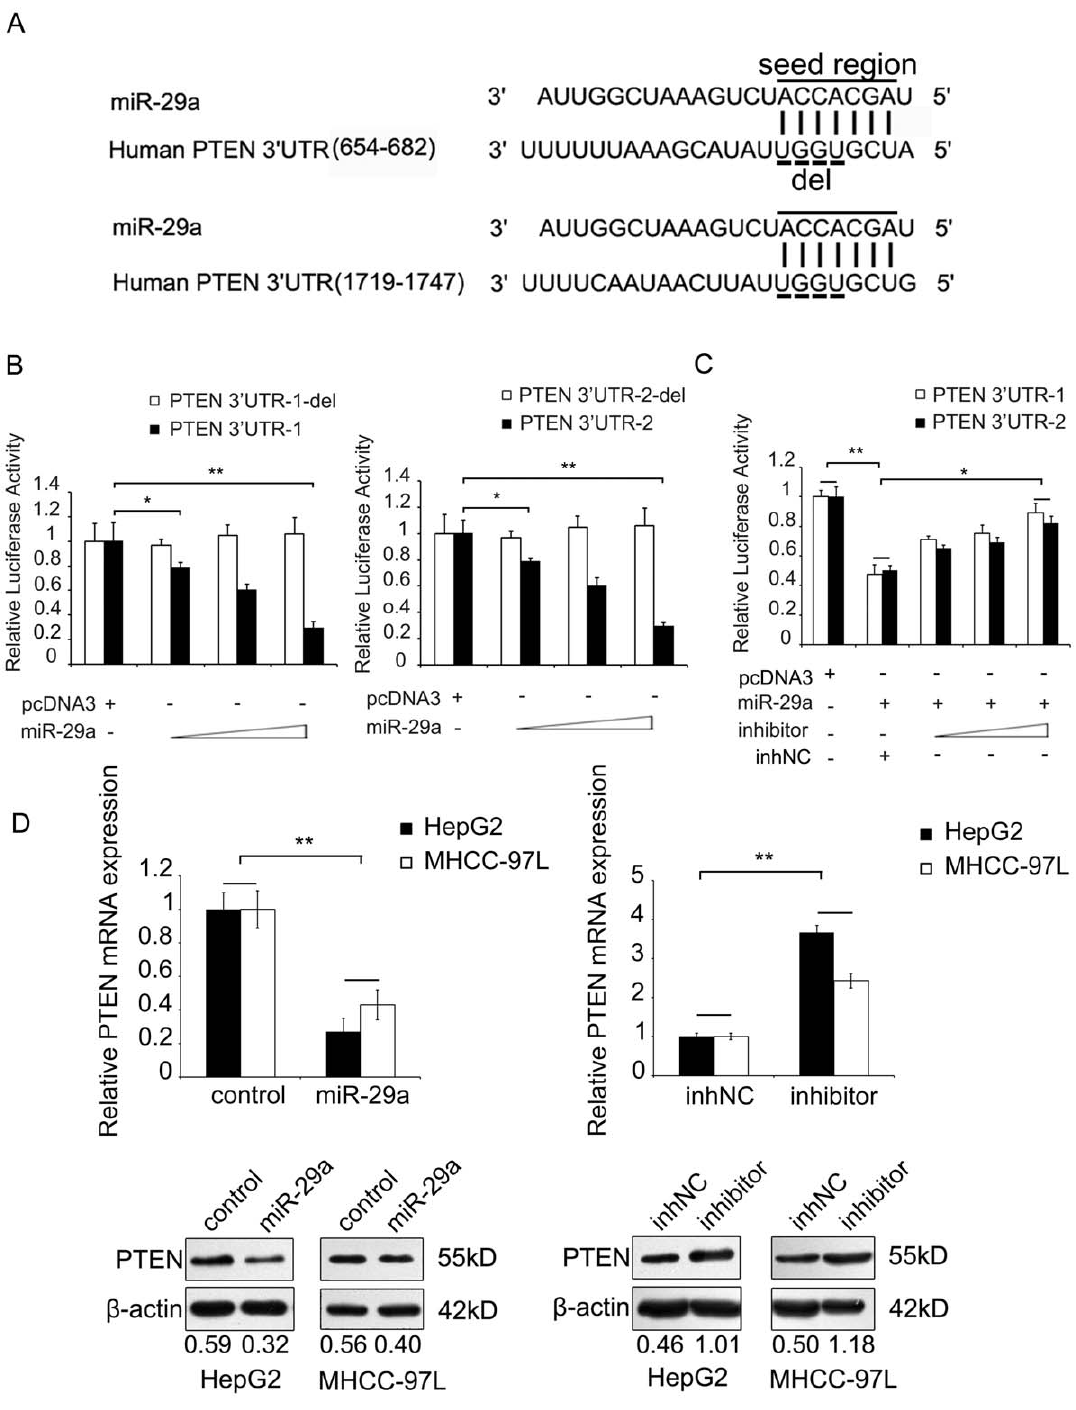
Figure 3. MiR-29a targets PTEN. (A) Sequence alignment between miR-29a and the 3 9 UTR of human PTEN mRNA. Solid line, seed match region; dashed line, seed-deleted region. (B) Luciferase reporter gene assay showed the effect of miR-29a on the activity of PTEN 3 9 UTR reporter. Co- transfection was performed using the plasmids, such as human PTEN 3 9 UTR (PTEN 3 9 UTR-1 or PTEN 3 9 UTR-2) or the miR-29a-binding site-deleted (del) PTEN 3 9 UTR (PTEN 3 9 UTR-1-del or PTEN 3 9 UTR-2-del), a miR-29a expression plasmid (50, 100, and 200 ng), in HepG2 cells. Empty pcDNA3.0 plasmid (200 ng) was used as a negative control. (C) Luciferase reporter gene assay showed that the decreased luciferase activities of PTEN 3 9 UTR reporter (PTEN 3 9 UTR-1 or PTEN 3 9 UTR-2) in HepG2 cells mediated by miR-29a overexpression (200 ng) was rescued by a miR-29a inhibitor in a dose dependent manner (30, 50, and 100 nM). (D) Immunoblot and qRT-PCR showed that miR-29a (3 m g, 6-cm plate) induced a decrease in endogenous human PTEN protein and mRNA in HepG2 and MHCC-97L cells, which was increased by transfection with a miR-29a inhibitor. GAPDH and b -actin were used as internal controls. Protein bands were quantified using Quantity One software (Bio-Rad). The value under each lane indicates the relative expression level of the PTEN, which is represented by the intensity ratio between PTEN and b -actin bands in each lane. Statistically significant differences are indicated: *P , .05, **P , .01, Student’s t test.